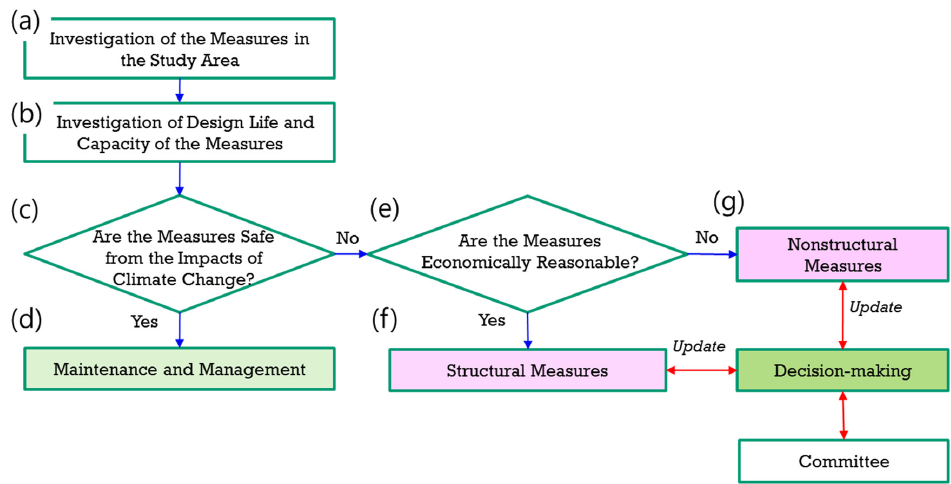
Figure 1. Decision-making procedure for applying a new design criteria considering climate change.